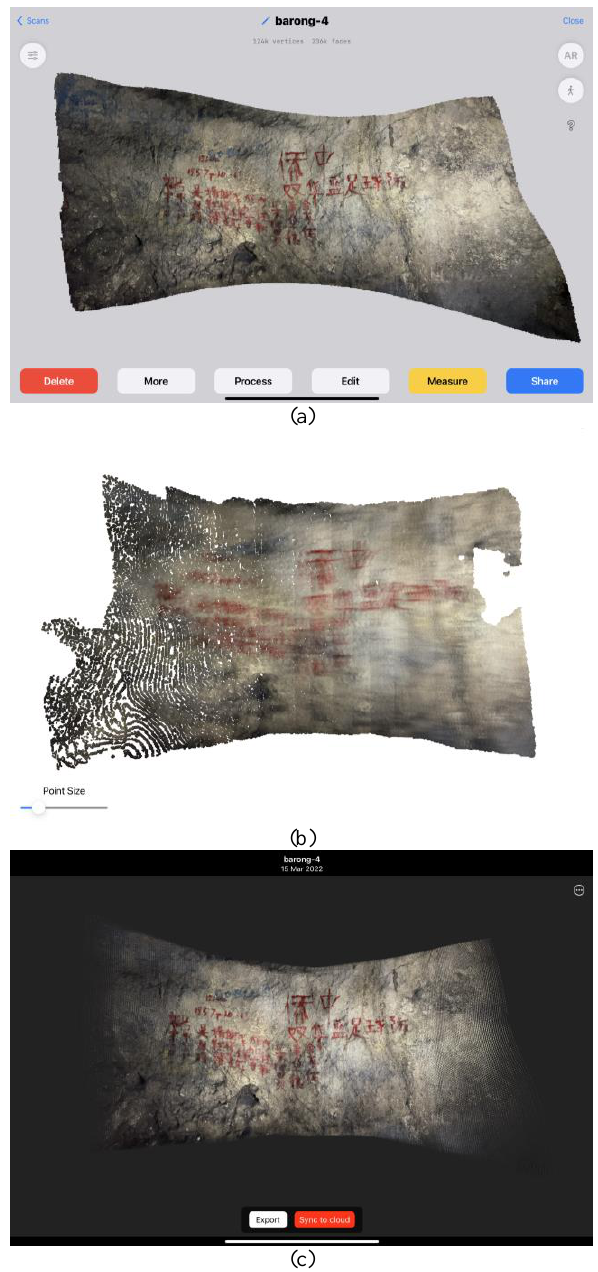
Figure 6. (a) The result of the 3D Scanner App that has gone through the texture process. (b) EveryPoint results, and (c) SiteScape results, both in the form of a point cloud.